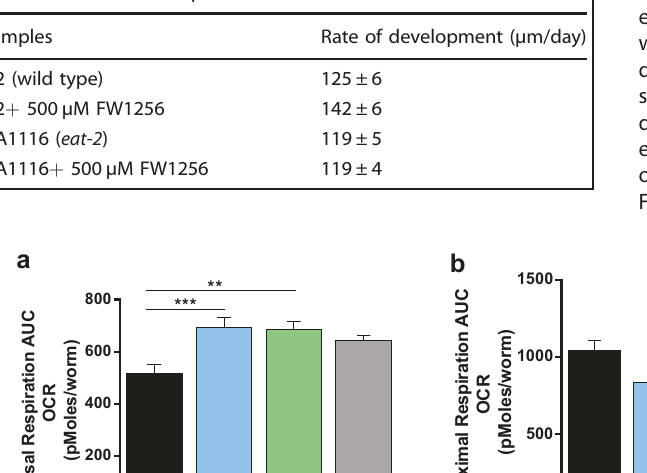
Table 2. Rate of development.